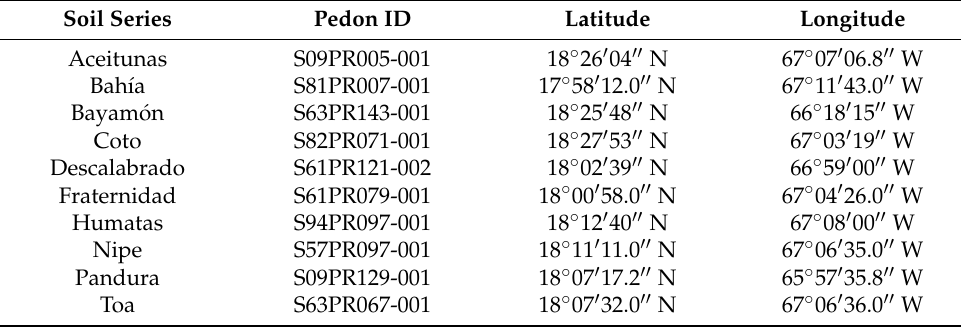
Table 3. Coordinates of soil pedons nearest K sat measurement